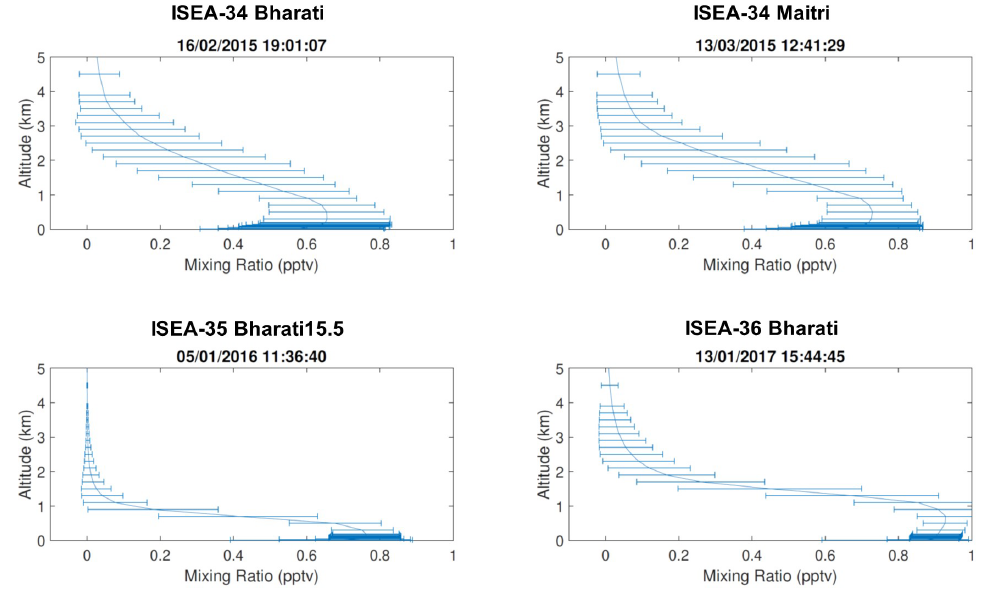
Figure 8. Typical examples of IO vertical profiles retrieved during all four campaigns are shown. The times are in